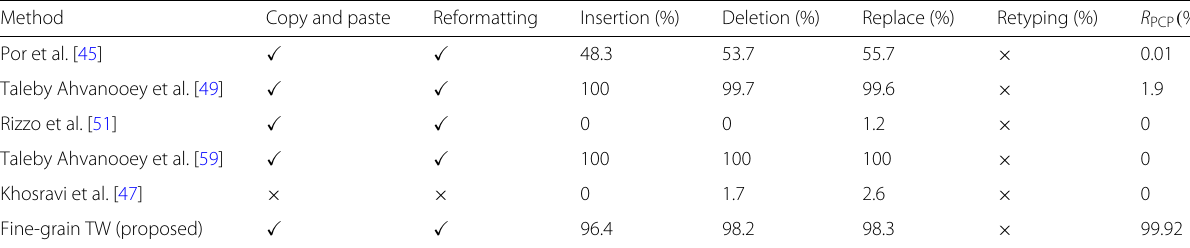
Table 5 Robustness evaluation and comparison